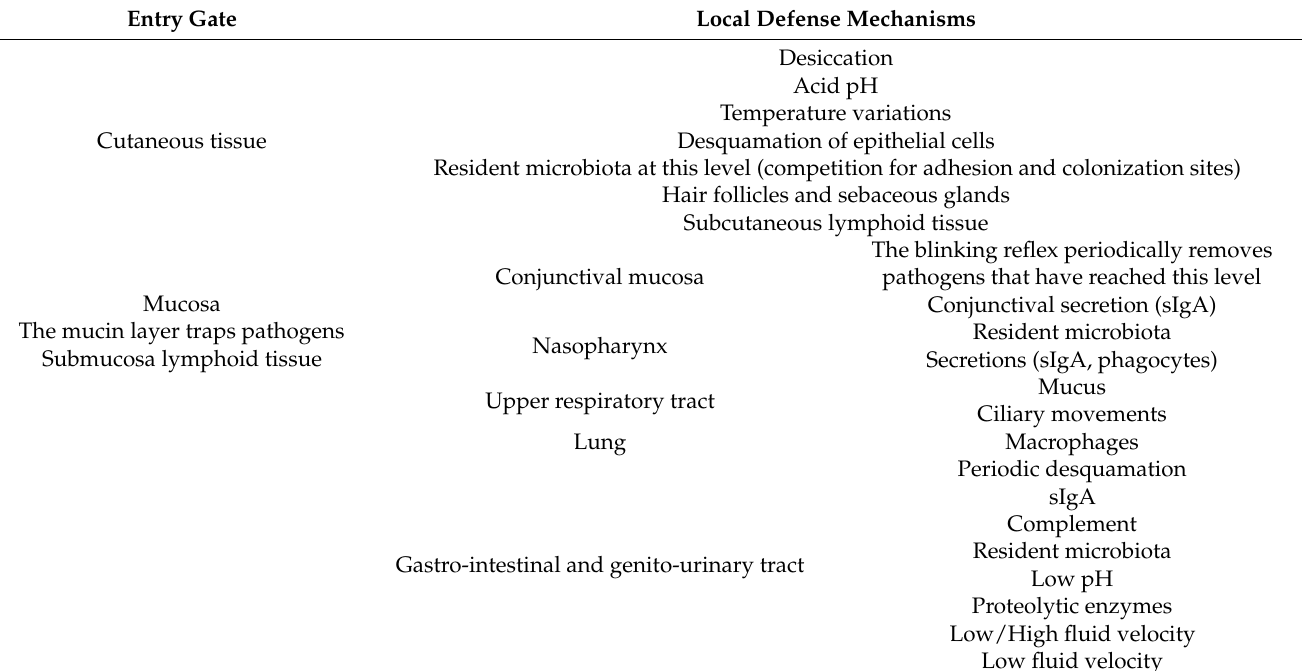
Table 1. The mechanisms of the anti-infectious cutaneous-mucosal barrier.